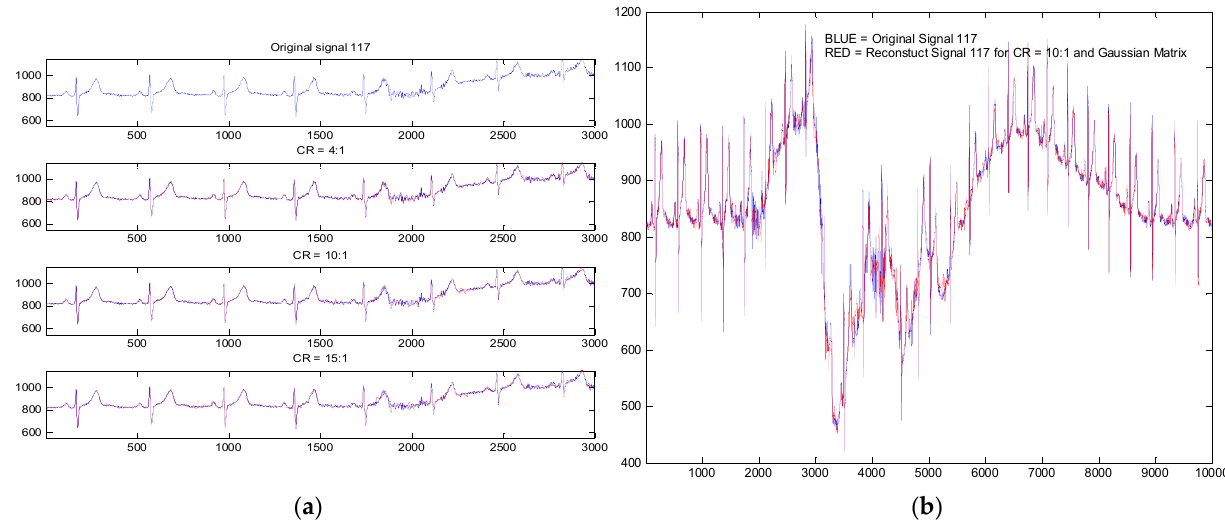
Figure 4. Original (blue) and reconstruct (red) ECG signal with PSCCS method (registration no. 117): ( a ) for CR 4:1, 10:1 and 15:1 with a Bernoulli projection matrix; ( b ) for CR 10:1 with random projection (Gaussian distribution).